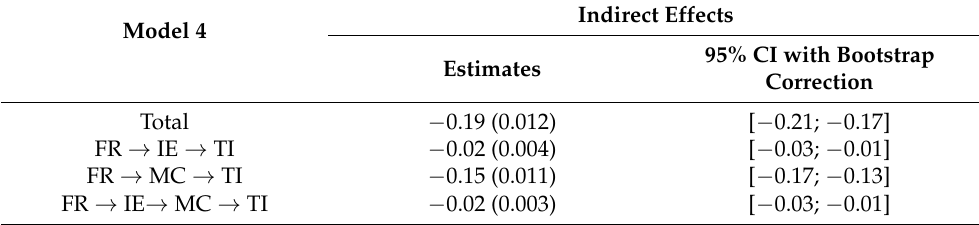
Table 8. Indirect effects of model